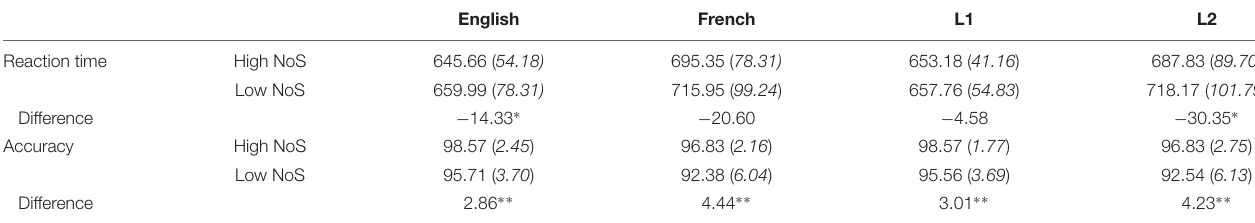
TABLE 5 | Mean RT (SD) and accuracy (SD) for bilinguals in the lexical decision task in English and French, and in the L1 and